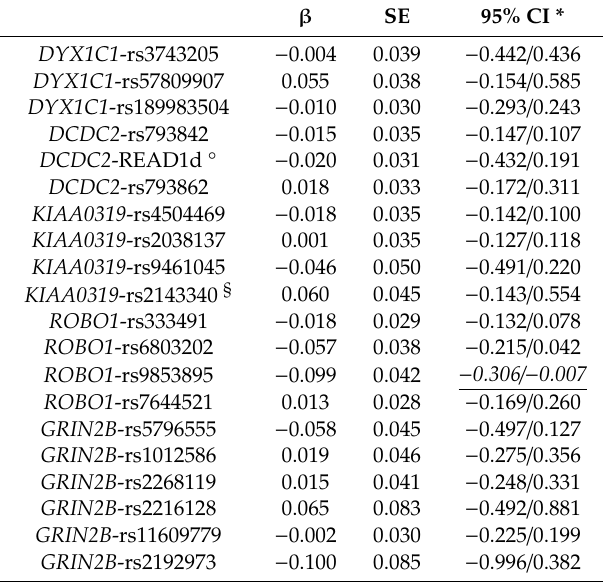
Table 3. Total indirect e ff ects from single nucleotide polymorphisms (SNPs) to reading in the multiple-predictor / multiple-mediator model (standardized β s and SEs are reported).